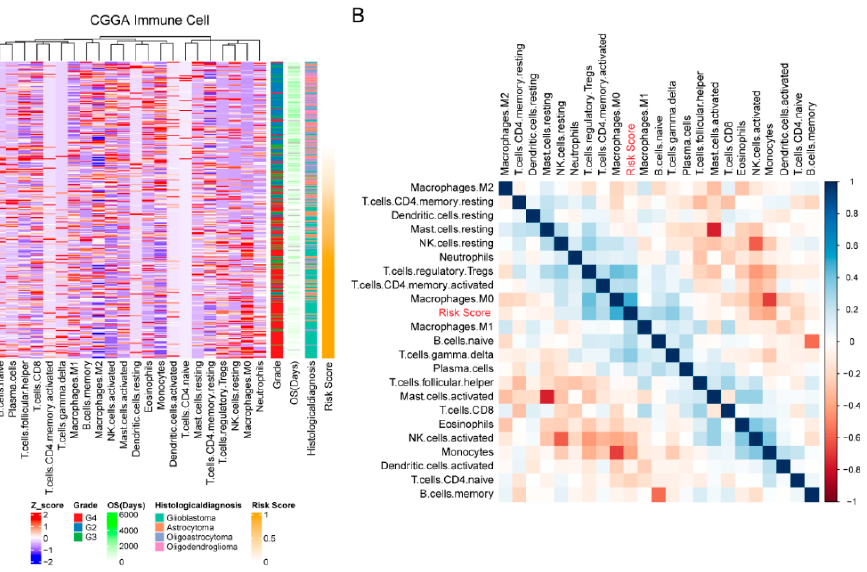
Figure 5. The 10-gene risk signature distinguished different local immune states in gliomas. ( A ) Analysis of heat map in CGGA dataset. ( B ) Correlation analysis in CGGA dataset.